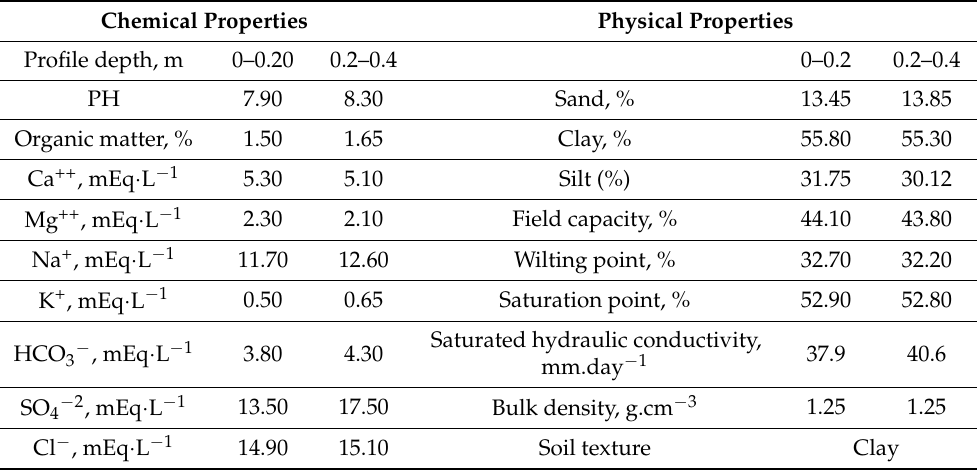
Table 1. Soil properties at the experimental field.